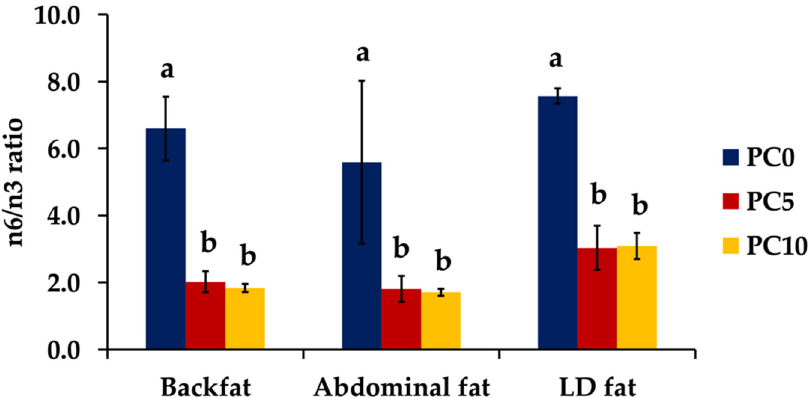
Figure 2. Effect of dietary perilla cake supplementation on the ratio of n6/n3 in backfat, abdominal fat, and longissimus dorsi muscle (LD). Superscription ( a and b ) indicates significant differences ( p < 0.05) between groups in each fat tissue. PC0, control; PC5, 5% perilla cake supplementation; PC10, 10% perilla cake supplementation.